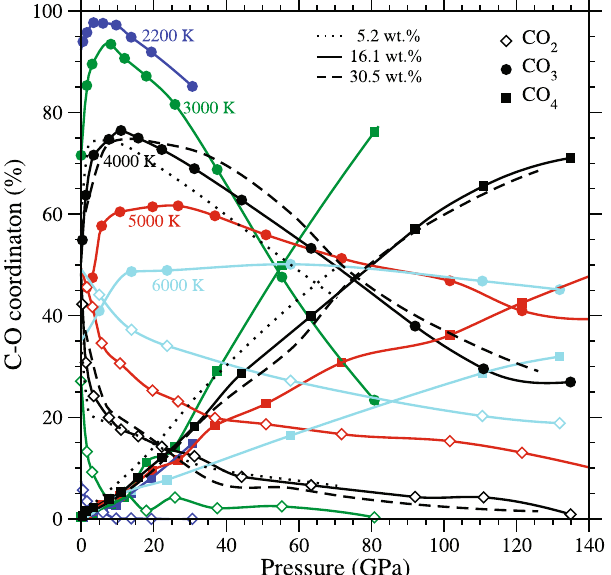
Figure 1. Speciation of carbon dioxide in MgSiO 3 liquid. Calculated abundances of different C-O coordination species (correspondingly, CO 2 speciation forms) in MgSiO 3 liquid: CO 2 molecules (diamonds), carbonate ions (circles), and CO 4 groups (squares). The results for 16.1 wt.% CO 2 are shown as a function of pressure at various temperatures (lines with symbols) compared with other concentrations at 4000